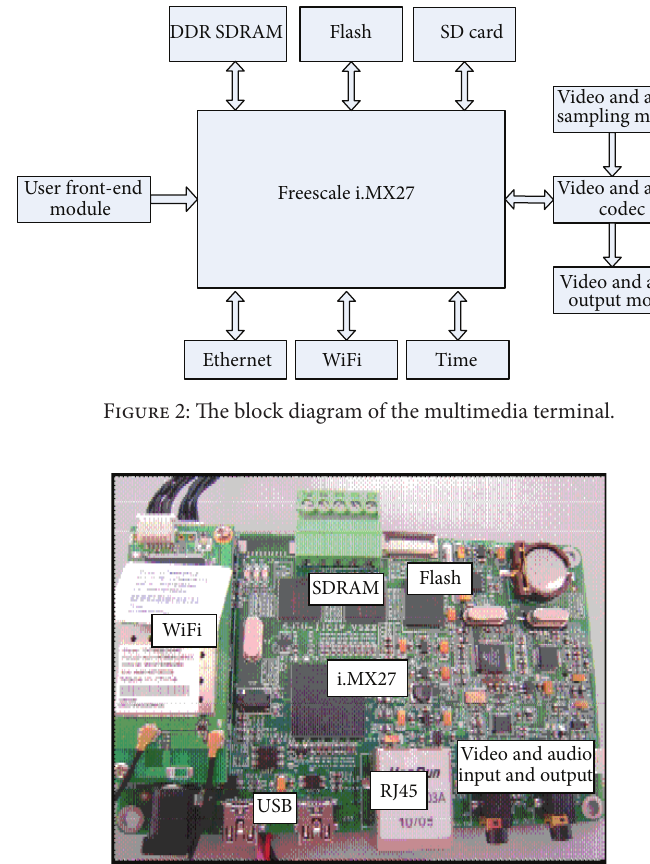
Figure 3: The circuit board of the embedded multimedia terminal.